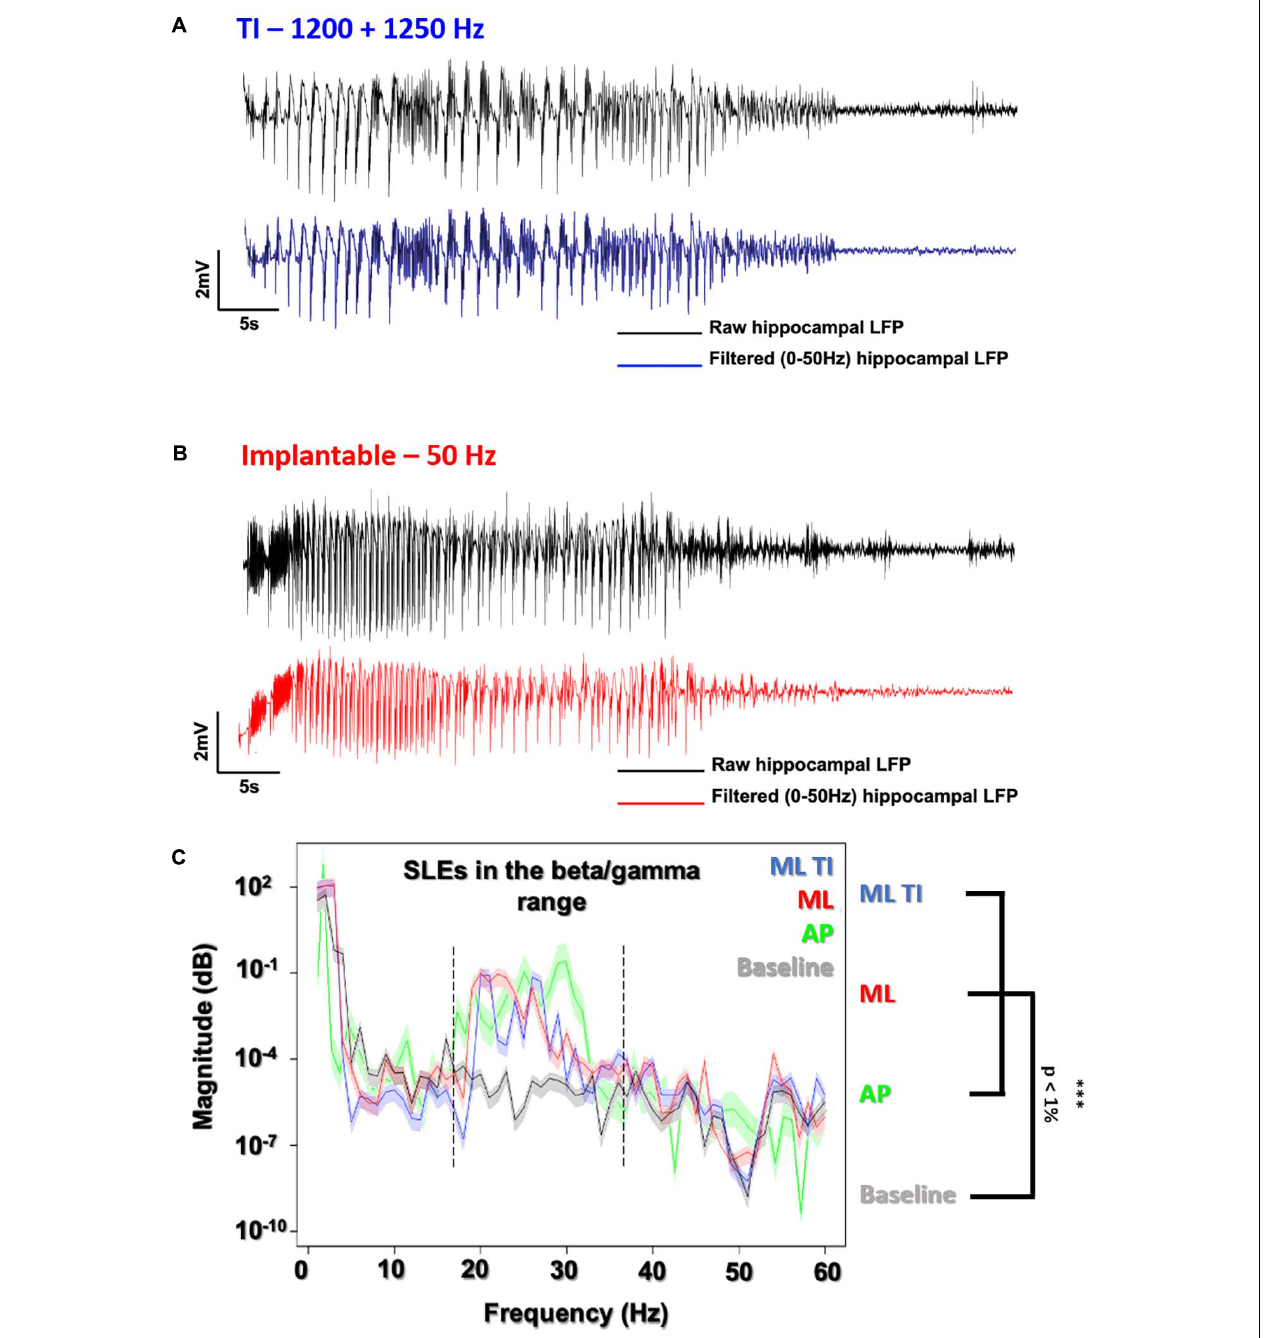
FIGURE 5 | Evoked SLEs using TI vs. implantable electrodes. LFP recording of freely moving mice after a 600 µ A stimulation using the preferential ML orientation. (A) All recordings (ML-ot-TI in blue and ML-implantable in red) were analyzed using a 50 Hz lowpass filter to clearly distinguish the SLE. (B) The classic implantable stimulator provides a 50 Hz applied stimulation in the hippocampus. TI provides a 50 Hz stimulation, corresponding to the differences between the two stimulation frequencies in the hippocampus (1200 and 1250 Hz). (C) Power Spectral Density (PSD) shows SLEs (15s after the stimulation) with a peak in the 20–40 Hz band (Beta/Gamma) characteristic of a rapid discharge for both implantable orientations (ML and AP) and ML-TI stimulation